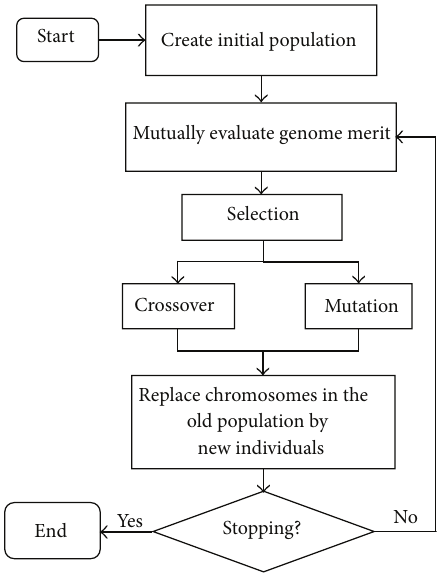
Figure 1: Flowchart of the proposed